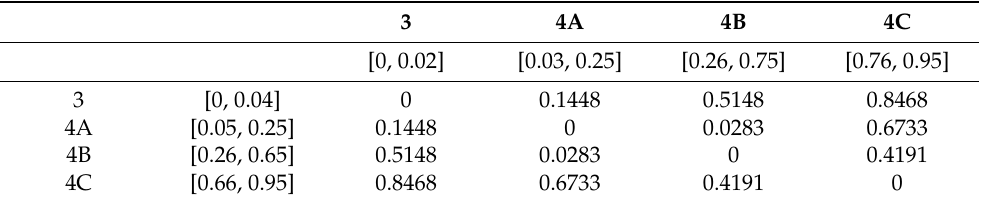
Table 4. Distance-based error between two TIRADS